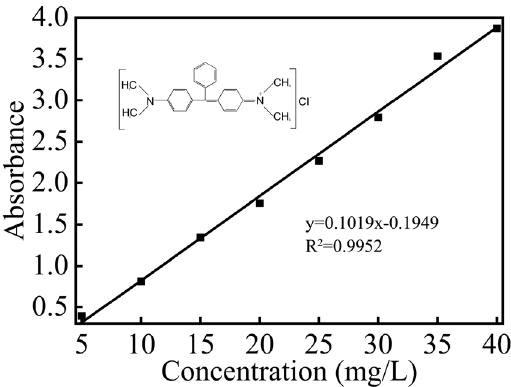
Figure 1: Standard curve of the MG dye concentration ( x ) versus absorbance ( y ) and its chemical